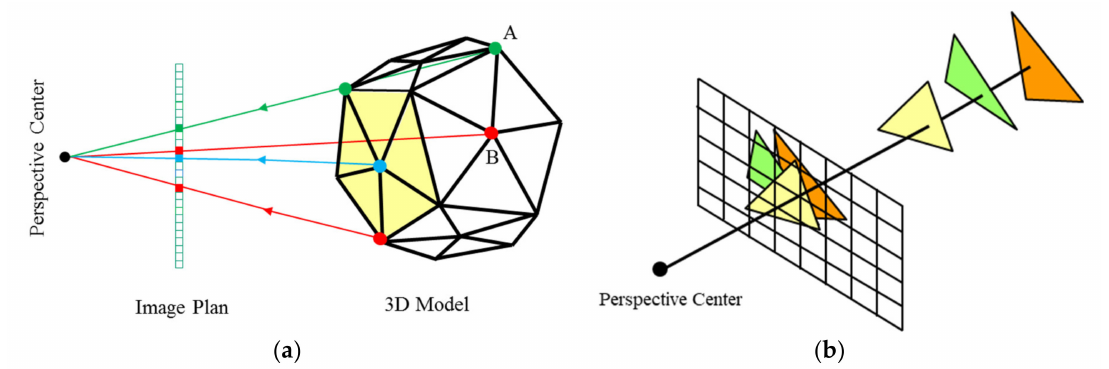
Figure 1. ( a ) Double mapping in texturing process, points A and B get spectral information while they are in shadow; ( b ) principle of Z–bu ff er